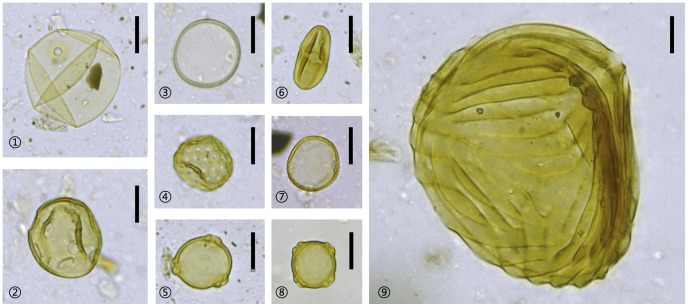
Pollen and spores from the Jiangli site.
 Poaceae (>40 µm); 
Liquidambar;  Poaceae (<40 µm);  Chenopodiaceae; 
Betula; 
Castanopsis; 
Typha; 
Myriophyllum; <
Ceratopteris. Scales  = 20 µm.